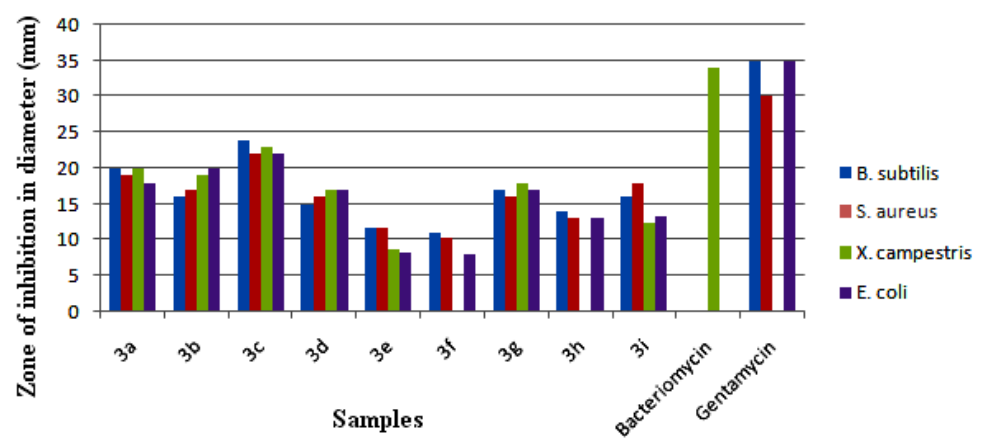
Figure 12. In vitro antibacterial activities of 3 ( a – i ).